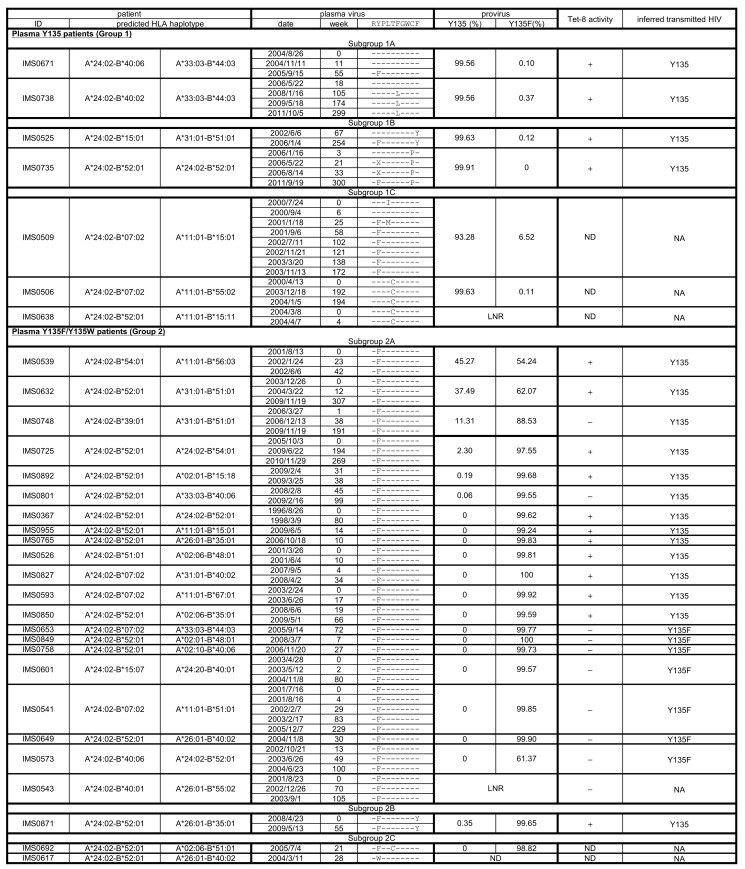
HLA haplotypes, longitudinal plasma viruses and inferred transmitted HIV.Suggested HLA haplotypes and longitudinal plasma viruses of the study patients are shown. Transmitted viruses were inferred based on viral sequence and immune response. LNR, Low Number of Reads; ND, Not Determined; NA: Not applicable.